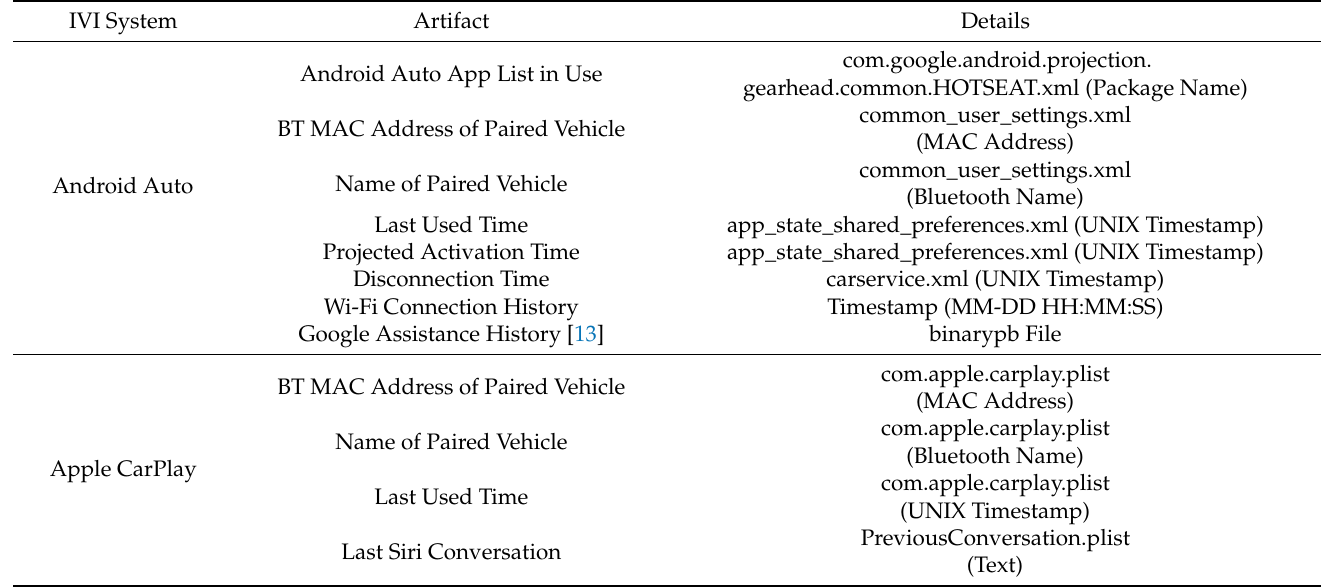
Table 6. List of Artifacts in Mobile Device Internal